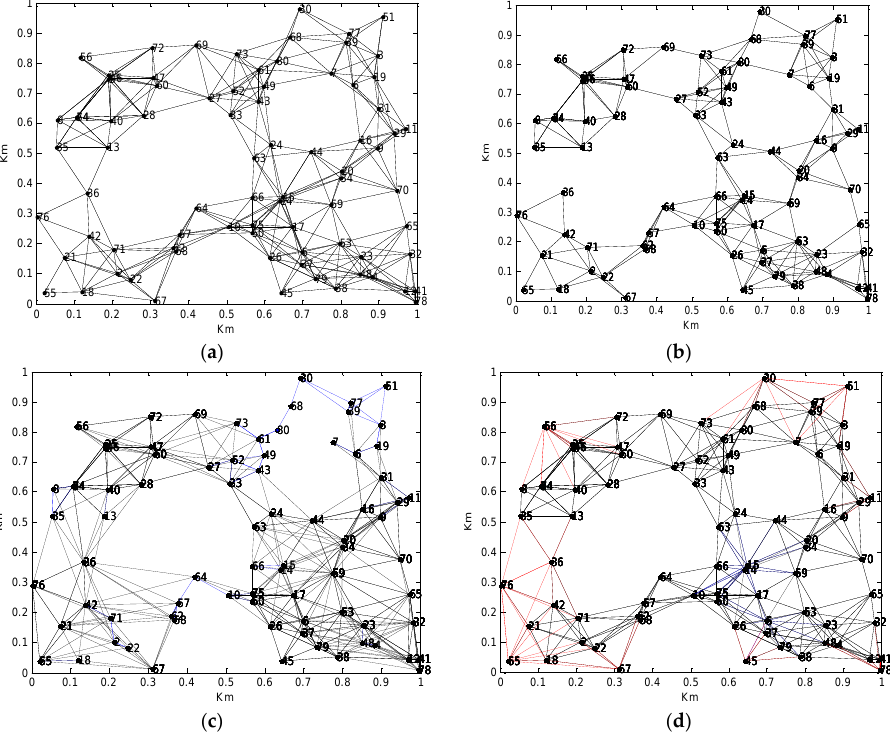
Figure 11. The simulation result: ( a ) NONE; ( b ) ERTC; ( c ) Local Mean Neighbor (LMN); and ( d ) Local Mean Algorithm (LMA). * The X -axis and Y -axis means the node distribution area. Both the LMA and LMN do not take the energy consumption into consideration. Moreover,